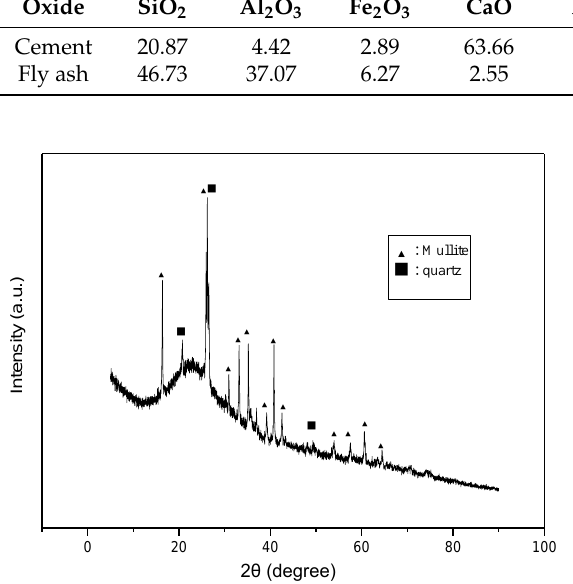
Figure 2. XRD pattern of the fly ash.